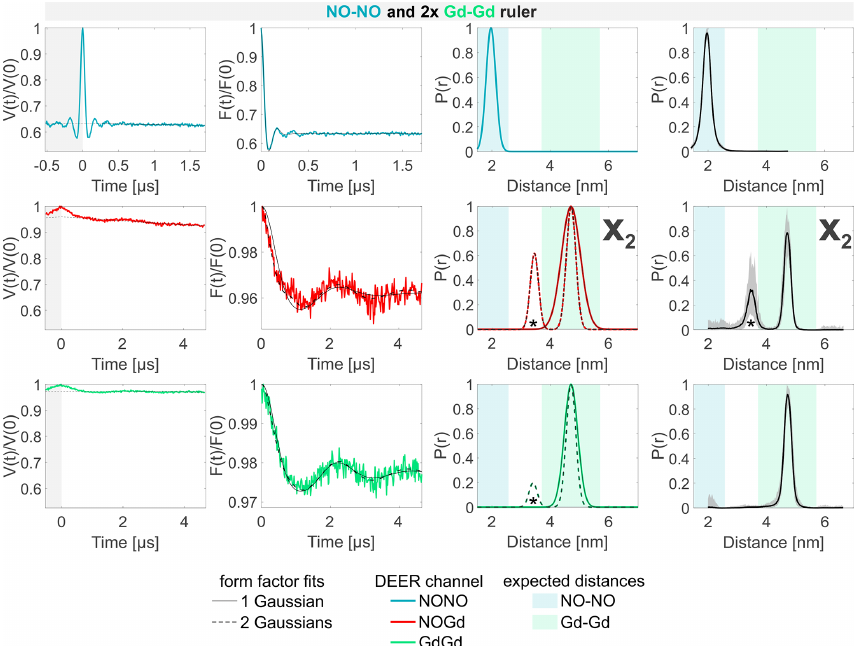
Figure 6. Sample containing the NO–NO and the Gd–Gd rulers mixed in a 1 : 2 molar ratio. The legend is the same as in Fig. 4. The form factors in the NOGd and in the GdGd channel were fitted using both a single Gaussian (solid line) and two Gaussians (broken line) to highlight the appearance of a spectrometer artifact corresponding to a 3.5nm distance (highlighted with an asterisk; see Fig. S8; part B). The NOGd DEER channel contains a Gd–Gd crosstalk signal in the absence of a NO–Gd distance designated as X 2 . A comparison of how different neural networks fit this crosstalk signal is shown in Fig. S9a (part B).